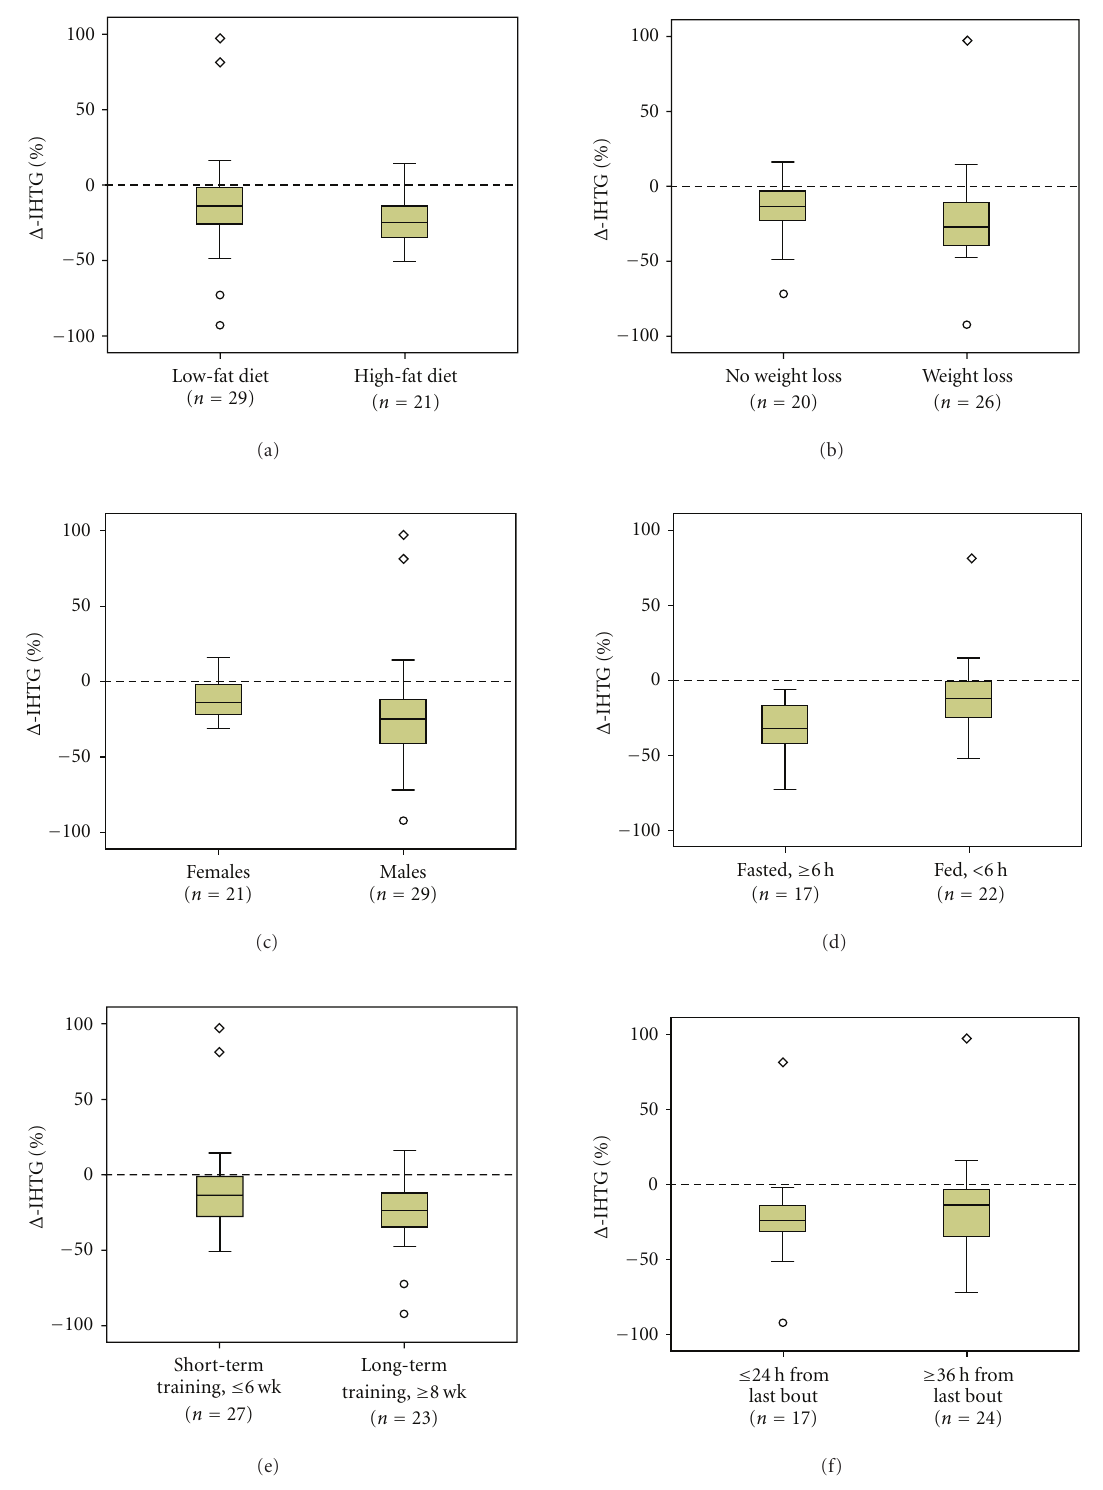
Figure 1: Factors that may a ff ect changes in liver fat in response to exercise training in animals. Exercise-induced changes in intrahepatic triglyceride content ( Δ -IHTG) are shown for: (a) animals fed high fat or standard chow (low fat) diets; (b) animals that experienced weight loss (or attenuated weight gain) or not; (c) male or female animals; (d) fasted or fed animals; (e) animals trained for longer or shorter periods of time; (f) animals examined within one day from the last bout of exercise or later during recovery. Box plots have been constructed using average changes in liver fat (% di ff erence relative to sedentary controls) for each group of animals in the studies depicted in Table 1, and illustrate median, first, and third quartiles, minimum and maximum values, as well as potential positive and negative